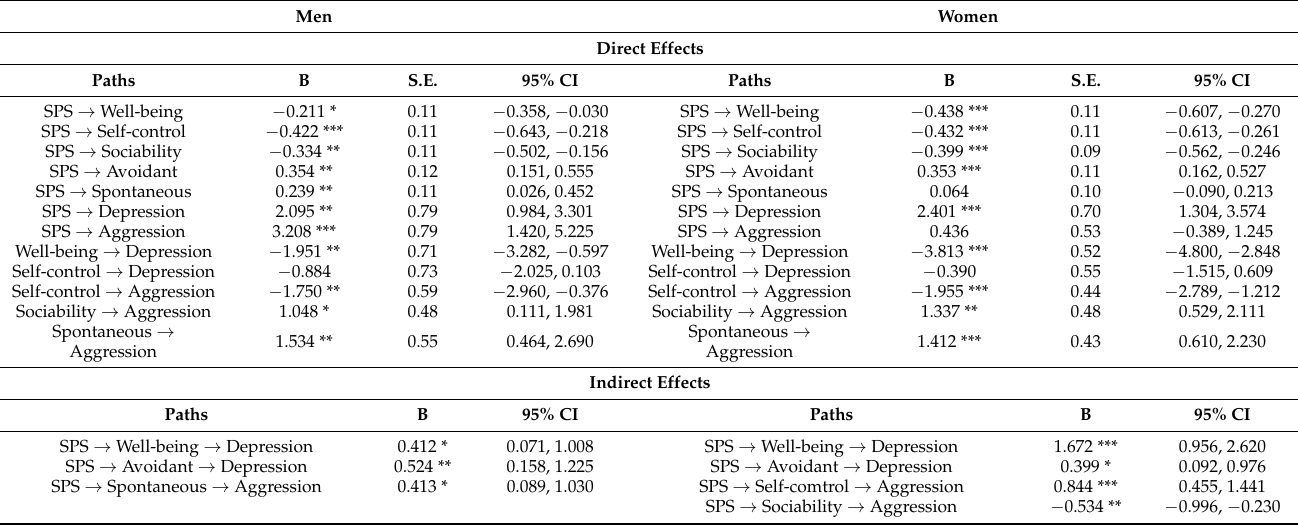
Table 4. Paths, unstandardized regression weights, and standardized errors for men and